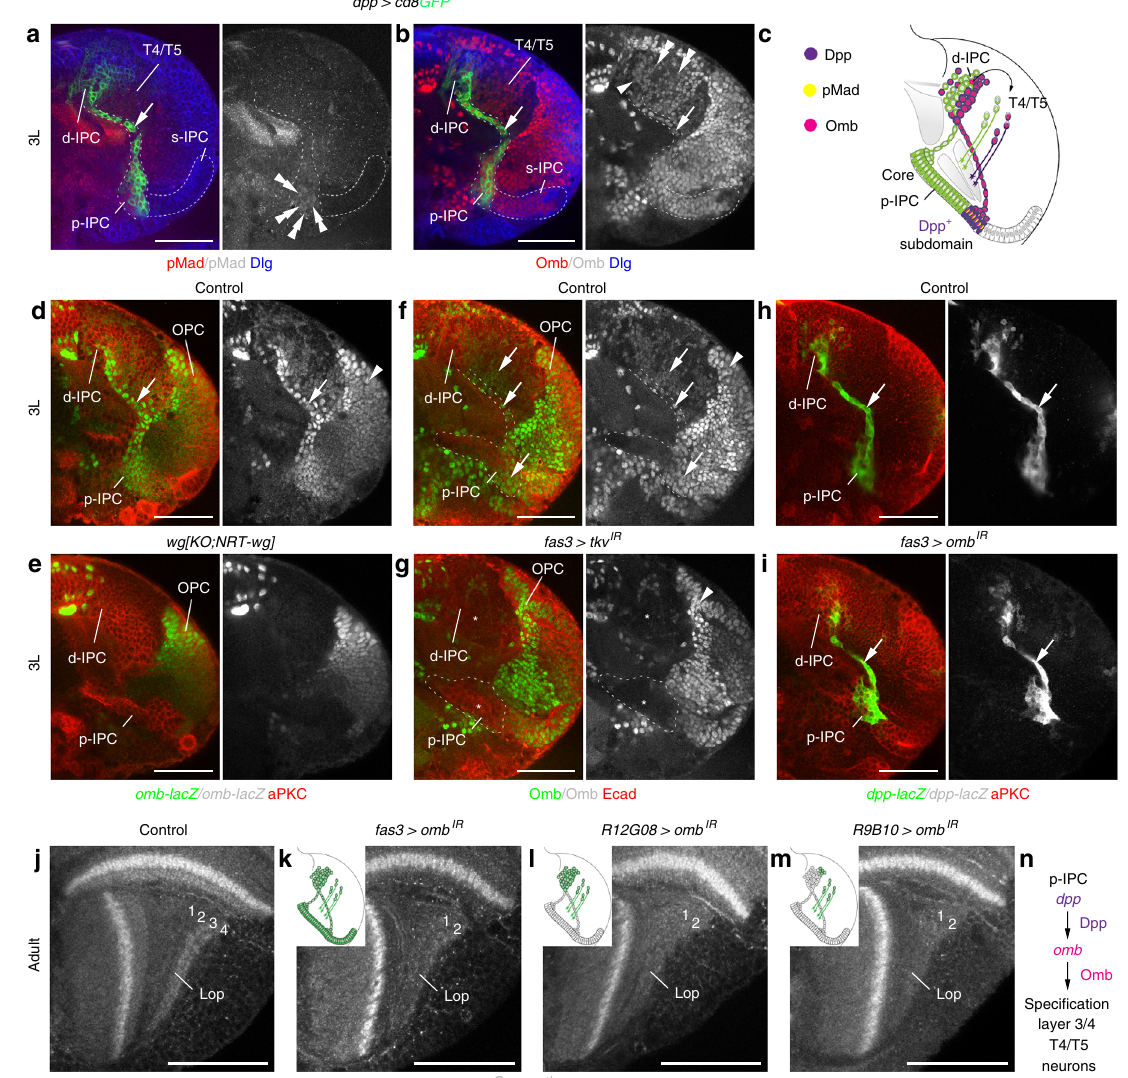
Fig. 7 Omb mediates Dpp-dependent speci fi cation of T4/T5 neurons for layers 3/4. a Phosphorylated Mad (pMad, red) in the dpp-Gal4 UAS-cd8GFP (green) expression domain was found in p-IPC NE cells (double arrowheads), but not in progenitors (arrow), d-IPC Nbs/GMCs, or T4/T5 neurons. b Omb (red) was maintained in the dpp-Gal4 UAS-cd8GFP (green) expression domain in progenitors (arrow), d-IPC Nbs/GMCs (arrowhead), and T4/T5 neuron subsets (double arrowheads). c Schematic illustrating pMad and Omb distribution within the Dpp expression domain. d , e Unlike in controls ( d ), omb P1 -lacZ (green) was absent from the IPC (arrow) in wg{KO;NRT-wg} fl ies ( e ). OPC expression (arrowhead) was not affected. f , g In controls ( f ), Omb protein (green) was detected in p-IPC subdomains, migratory progenitors, and progeny (arrows). Following fas3 NP1233 -Gal4 -mediated IPC-speci fi c tkv knockdown ( g ), expression was severely reduced in these cells (asterisks). OPC expression (arrowhead) was not affected. h , i Indistinguishable from controls ( h ), fas3 NP1233 -Gal4 -mediated IPC-speci fi c knockdown of omb ( i ) did not affect EMT of dpp-lacZ- labeled progenitors (green, arrow) in the IPC. j – m Unlike in controls ( j ), omb knockdown in the entire IPC and its progeny using fas3 NP1233 -Gal4 ( k ), in the d-IPC and postmitotic T4/T5 neurons using R12G08-Gal4 ( l ), and primarily postmitotic T4/T5 neurons using R9B10-Gal4 ( m ) resulted in the absence of Connectin-positive lobula plate layers 3/4. Schematic insets highlight cell type-speci fi cities of Gal4 lines in green. n Schematics summarizing the role of Dpp in inducing Omb expression to specify layer 3/4 innervating T4/T5 neurons. For genotypes and sample numbers, see Supplementary Table 1. Scale bars, 50 μ